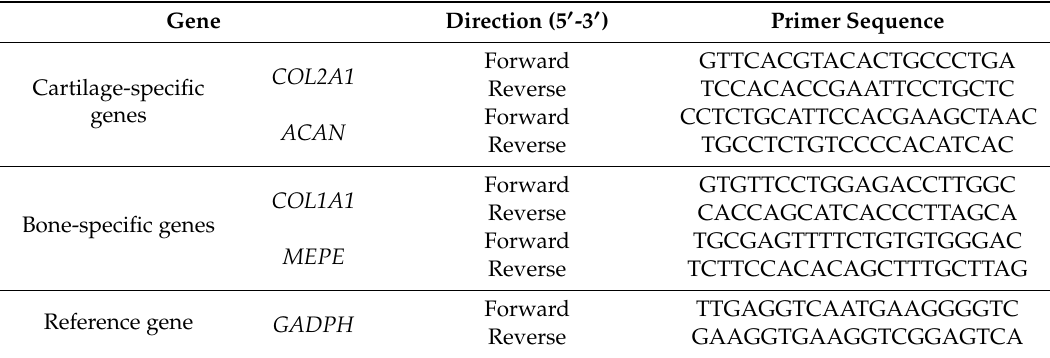
Table 2. RT-qPCR primers utilized for detection of osteogenic and chondrogenic gene expression. Gene Direction (5 (cid:48) -3 (cid:48) ) Primer Sequence Forward GTTCACGTACACTGCCCTGA COL2A1 Cartilage-specific Reverse TCCACACCGAATTCCTGCTC genes Forward CCTCTGCATTCCACGAAGCTAAC ACAN Reverse TGCCTCTGTCCCCACATCAC Forward GTGTTCCTGGAGACCTTGGC COL1A1 Reverse CACCAGCATCACCCTTAGCA Bone-specific genes Forward MEPE Reverse Reference